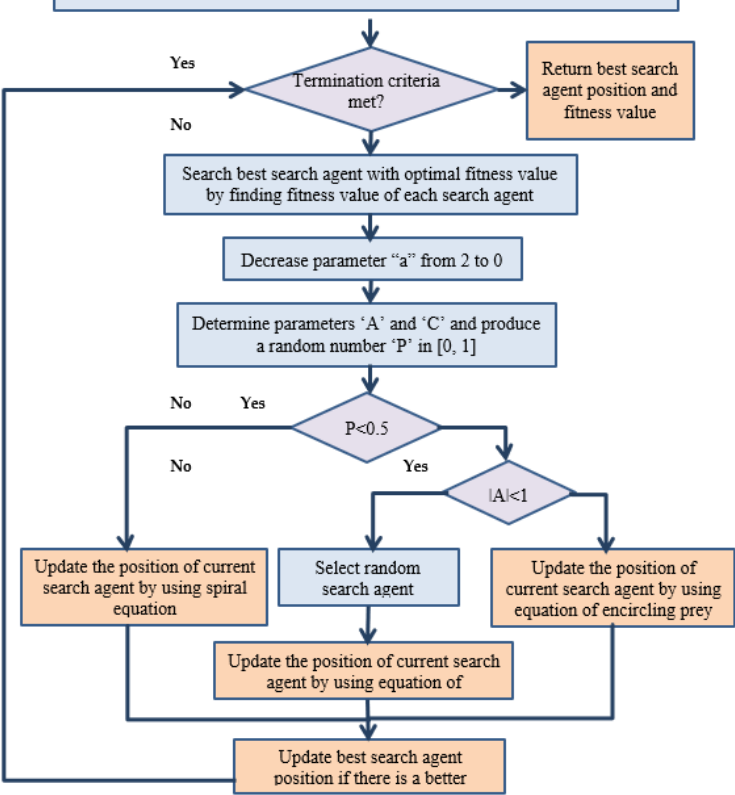
Figure 4. Flow Chart of WOA.